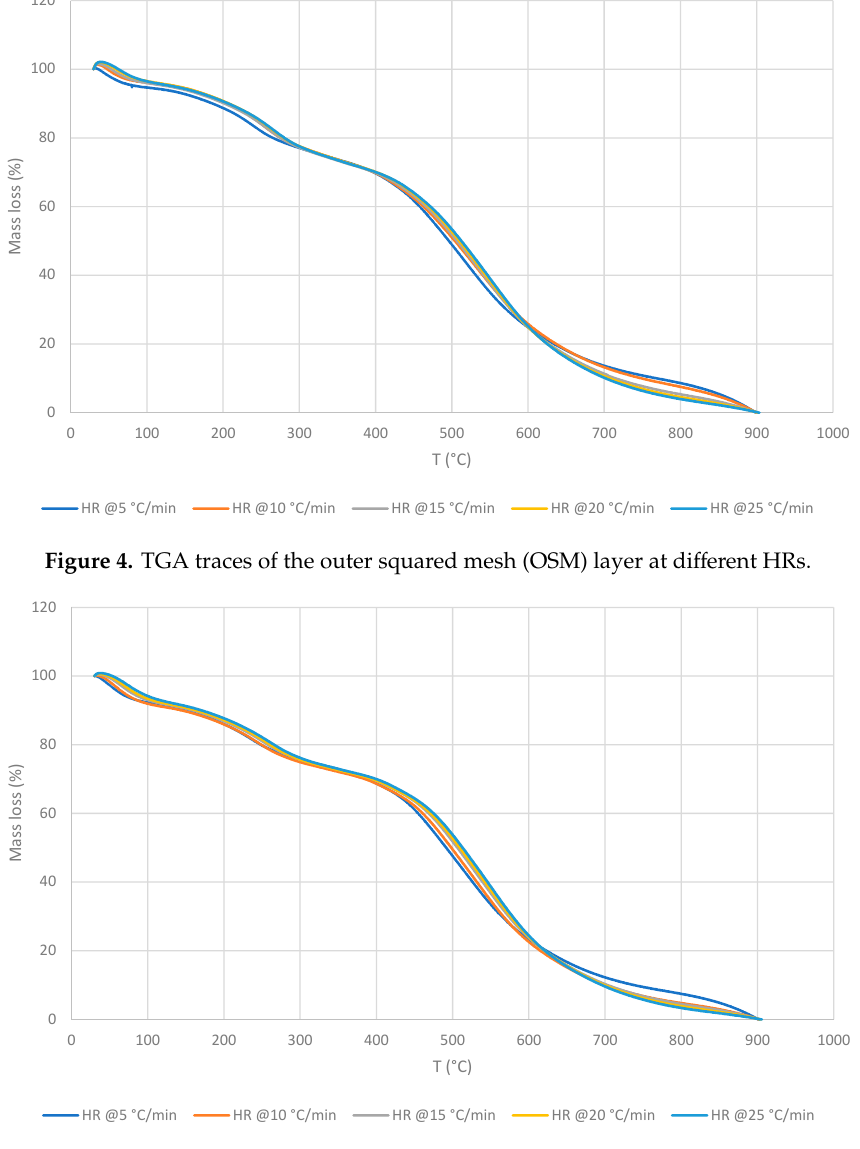
Figure 5. TGA traces of the inner material (IM) layer at different HRs.